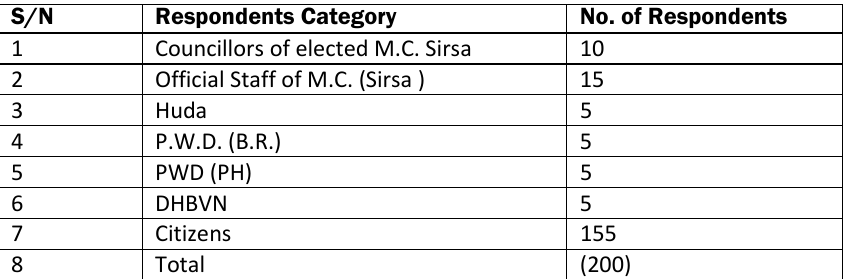
TABLE 1: Sample of the